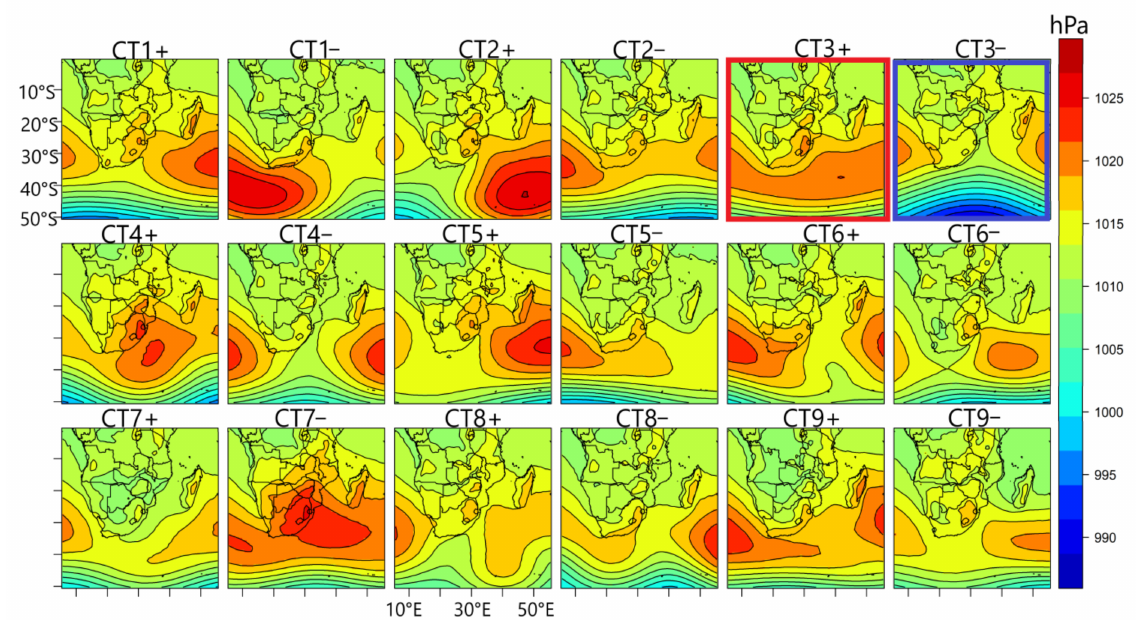
Figure 11. Circulation types classified from the EC-Earth CMIP6 GCM for the ssp585 experiment. The selected type related to the SAM are highlighted by the red frame (i.e., CT related to the positive SAM) and blue frame (i.e., the CT related to the negative SAM).